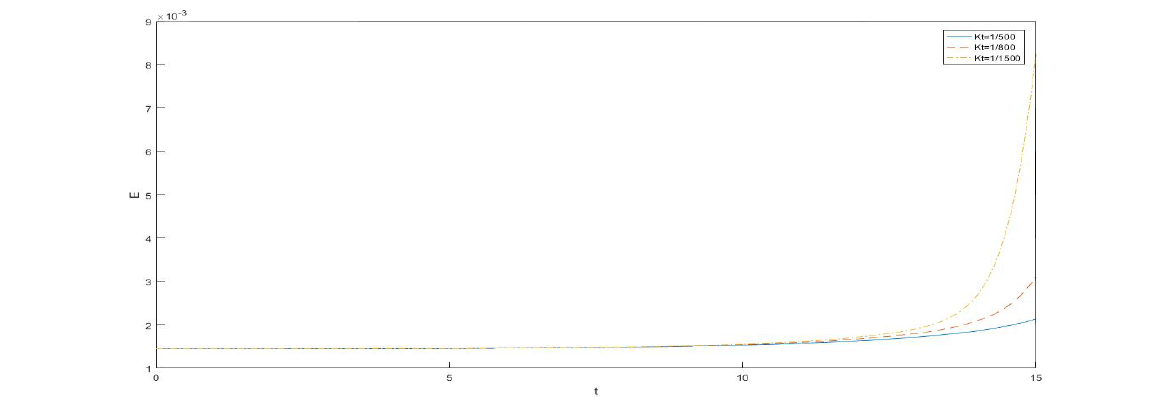
Fig. 3 The graph of the nonaxisymmetric portion ( E ) with m = 4 and α = 69 × 10 − 6